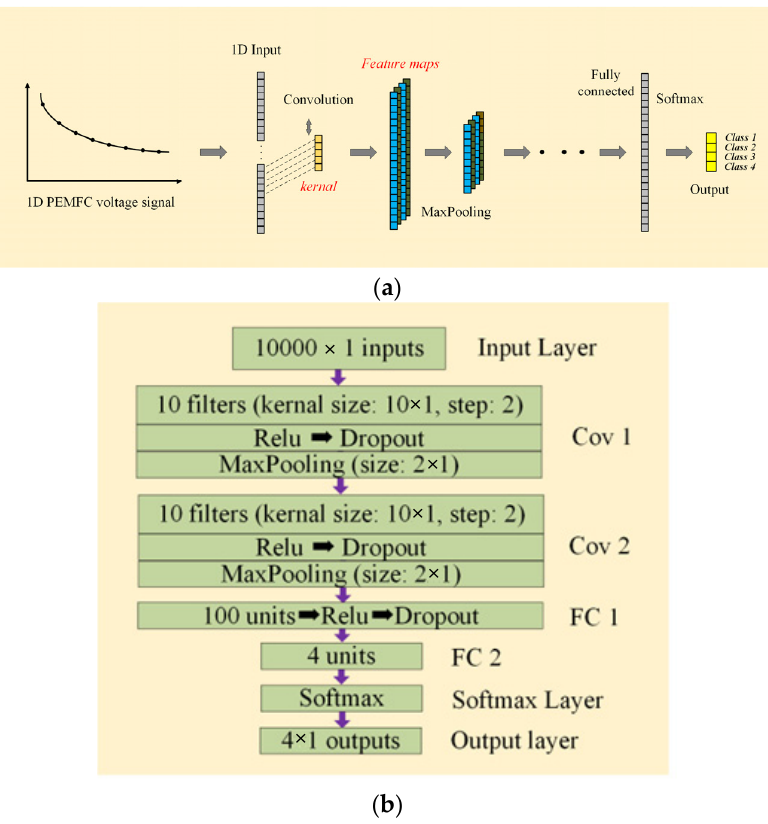
Figure 4. ( a ) Structure of the 1D-CNN model ( b ) Parameters of the 1D-CNN model.